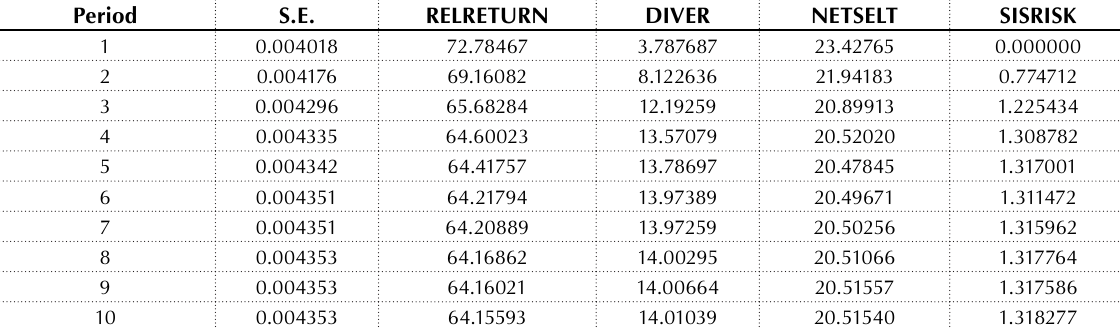
Table 5. Variance decomposition of NETSELT